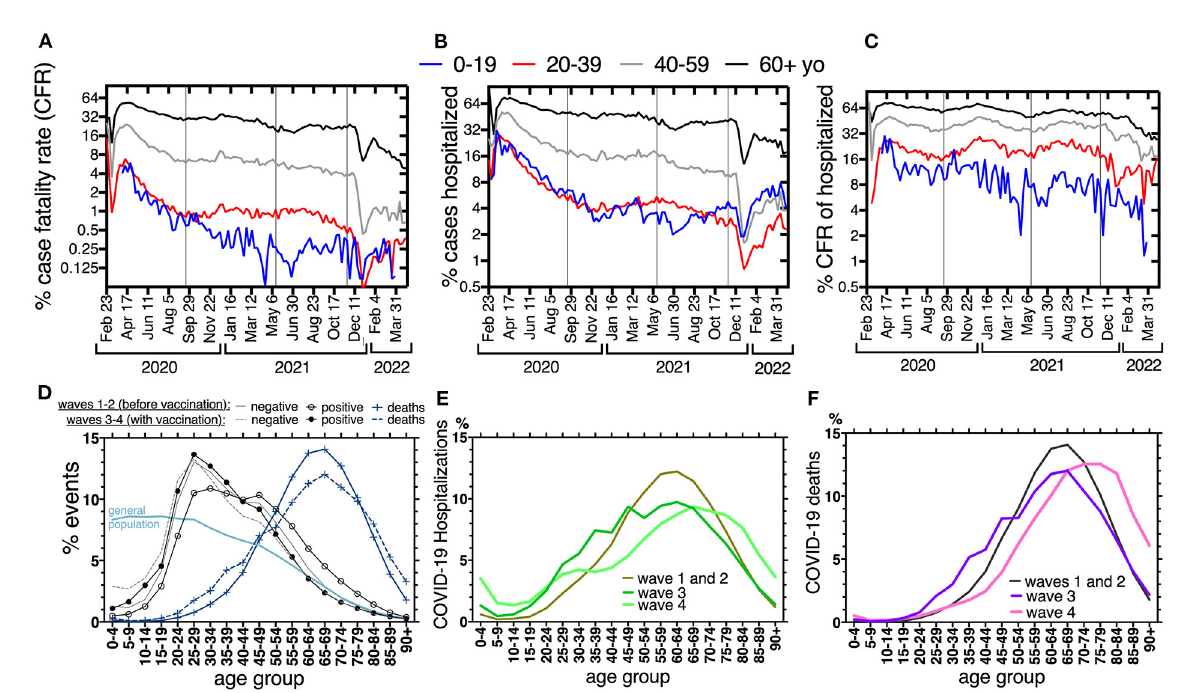
FIGURE4 (A) Percent case fatality rate (CFR), (B) percent cases that were hospitalized and (C) percent case fatality rate of those hospitalized, per week of symptom onset, across the first four waves (Feb-2020–Apr-2022), separated by age group: 0–19 yo blue lines, 20–39 yo red lines, 40–59 yo gray lines, 60 + black lines. In (A–C) y-axes are log 2, to favor curve display, and horizontal lines separate the waves, like in Figures 1A,B. (D–F) are the percent events separated into 5-year age groups, to appreciate age distribution across the population and waves. Waves 1 and 2, before vaccines, had a similar distribution and thus are displayed together. In (D) , waves 3 and 4 (when vaccination of adults happened) are displayed together. In (D) , events are: individuals with symptoms that tested negative or positive to SARS-CoV-2 and those that died from confirmed COVID-19. The pale blue line represents the age-distribution of the population pyramid in Mexico 2021 (“general population”), for reference. In (E,F) only COVID-19 hospitalizations and deaths are displayed, respectively. Waves 3 and 4 are separated to appreciate the differences in distribution as vaccination